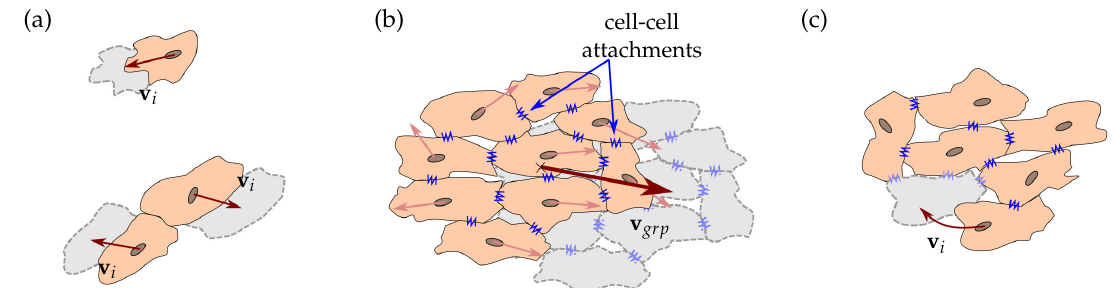
Figure 4. Cell migration. ( a ) Individual cell migration is considered when cells are separated or for cells which are not attached to another cell by CJ. v i is the individual cell velocity. ( b ) Collective cell migration is considered for each group of cells attached by cell junctions. Group velocity, v grp , is defined from the migratory tendency of the cells in the group. ( c ) Cell relocation is considered when group velocity is insufficient to consider the movement. A cell can migrate to a new position, with its individual velocity, v i , without leaving the